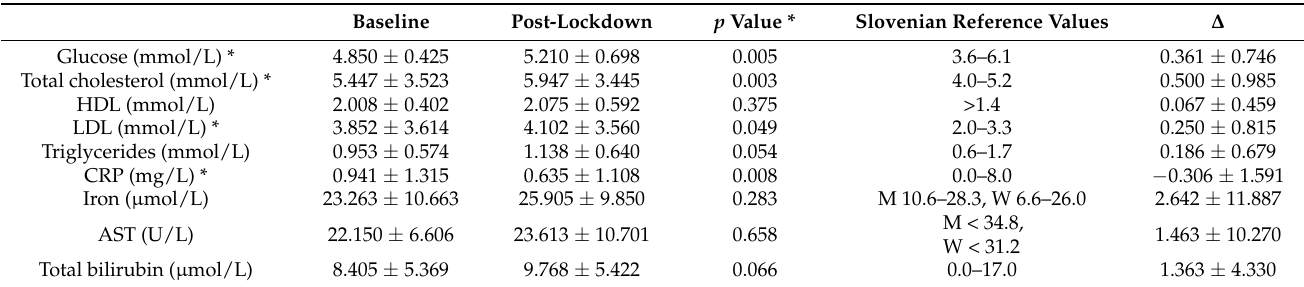
Table 6. Serum Markers in Asymptomatic Subjects at the Baseline and Post-Lockdown. Baseline Post-Lockdown